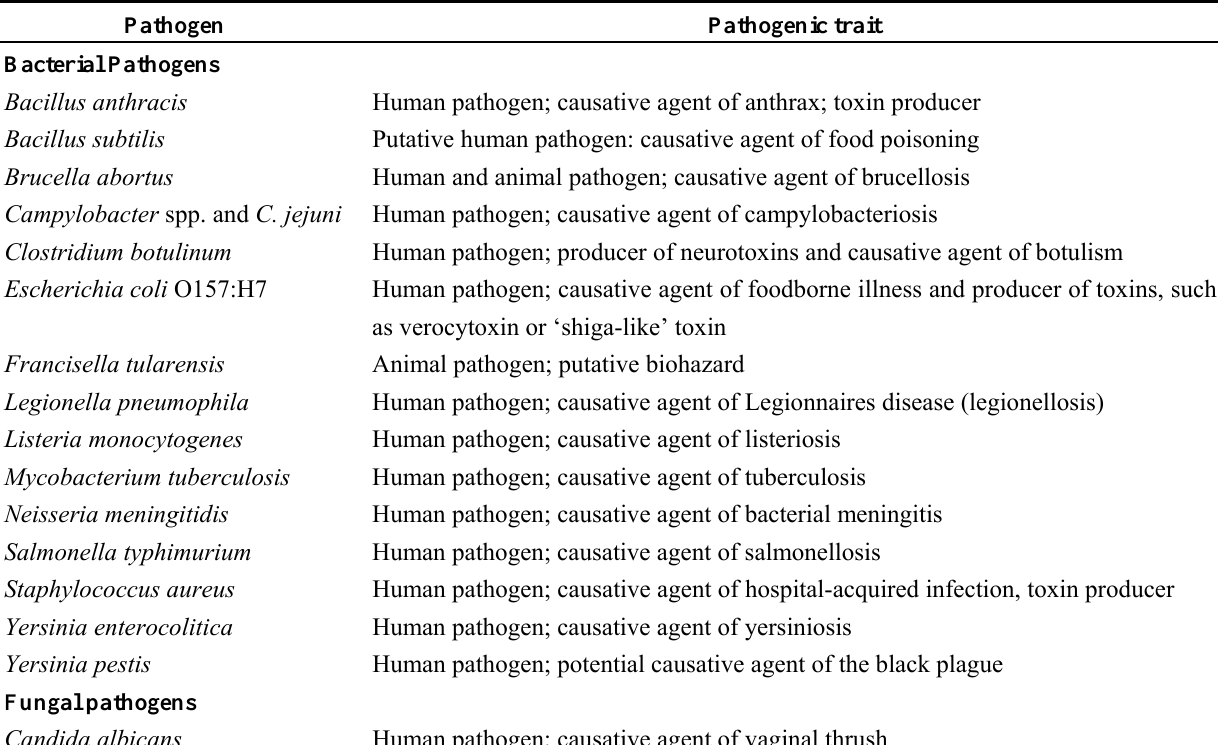
Table 1. A selection of pathogenic bacterial, fungal and viral strains and their virulence traits.